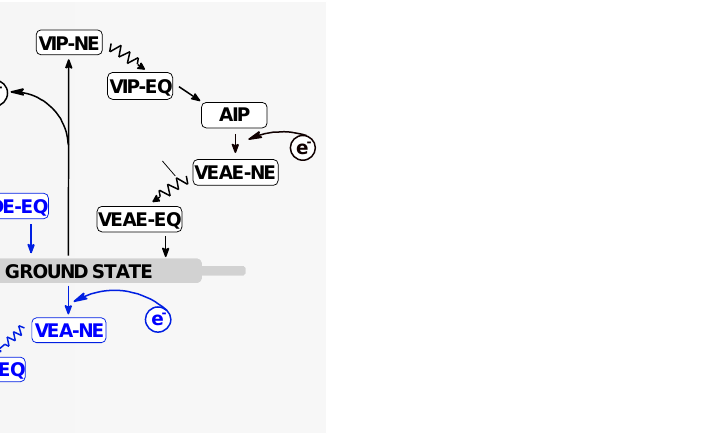
Figure 5. Graphical representation of electronic states and energie [eV] changes during the elec- tron/hole migration through ds-DNA. The abbreviations have been given in the Materials and Meth- ods section.